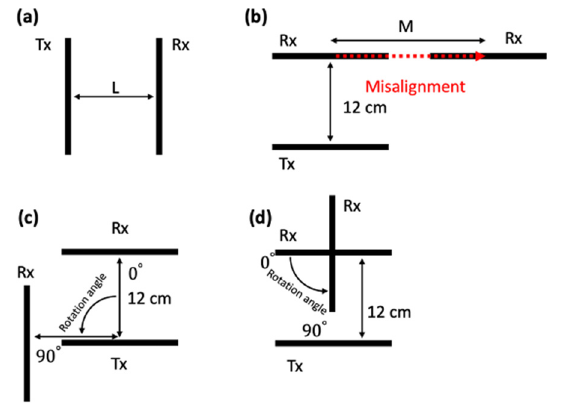
Figure 4. Top view of Tx and Rx in study of ( a ) the coil separation, ( b ) axial misalignment, ( c ) re- ceiver rotating around the transmitter and ( d ) the self-spinning of the receiver.